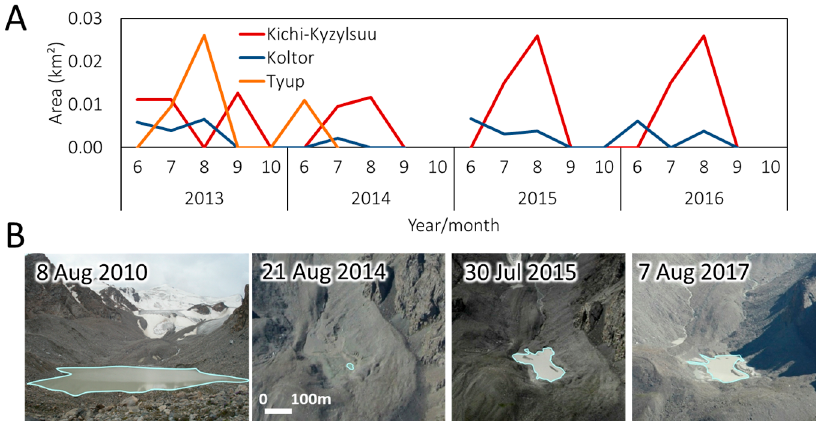
Figure 3. Recurring-type of short-lived lakes in the Teskey Range. ( A ) Inter-annual areal variations of the Kichi-Kyzylsuu, Koltor, and Tyup lakes (for locations, see Figure 1) between 2013 and 2016. ( B ) Images of the Koltor lake in 2010 (photo from fieldwork by authors), 2014, 2015, and 2017 (photos from helicopter by authors) with the boundaries highlighted.